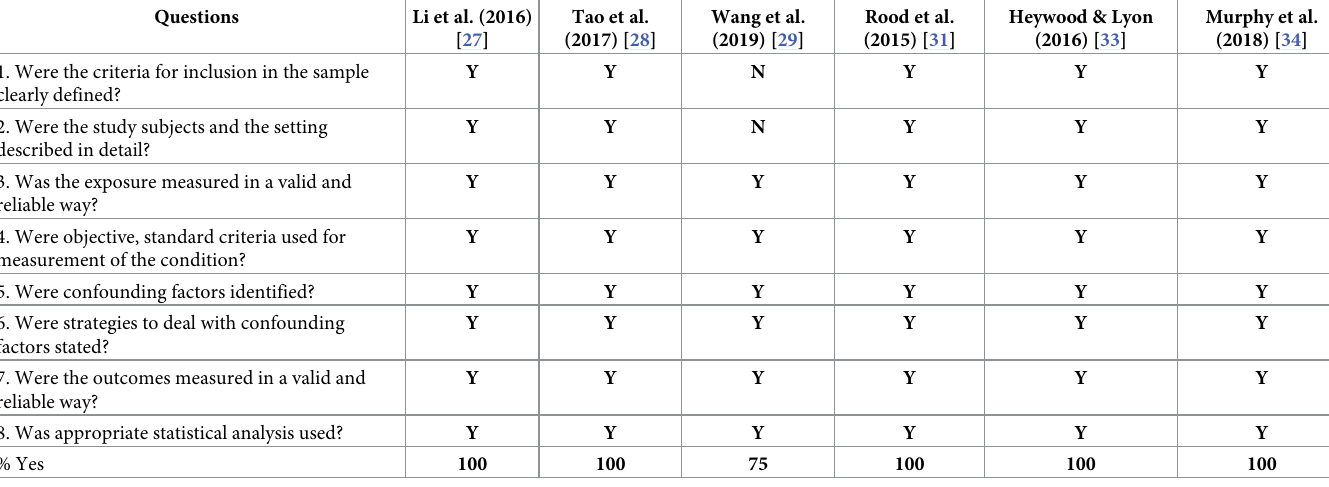
Table 2. Quality assessment of cross-sectional